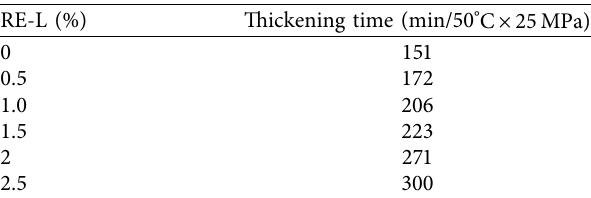
Table 6: Thickening time after the addition of different amounts of